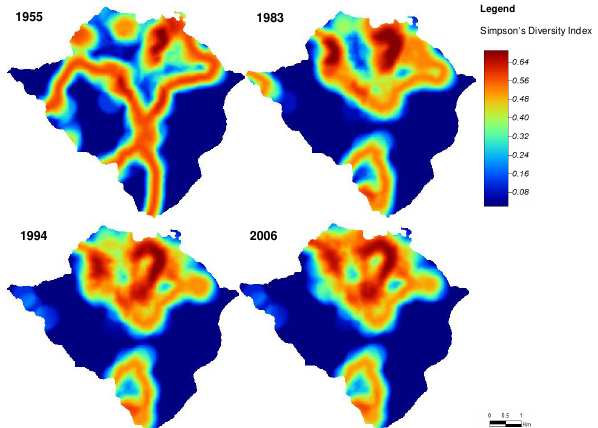
Fig. 8. Simpson’s Diversity Index (SIDI) calculated in FRAGSTATS environment using the moving window